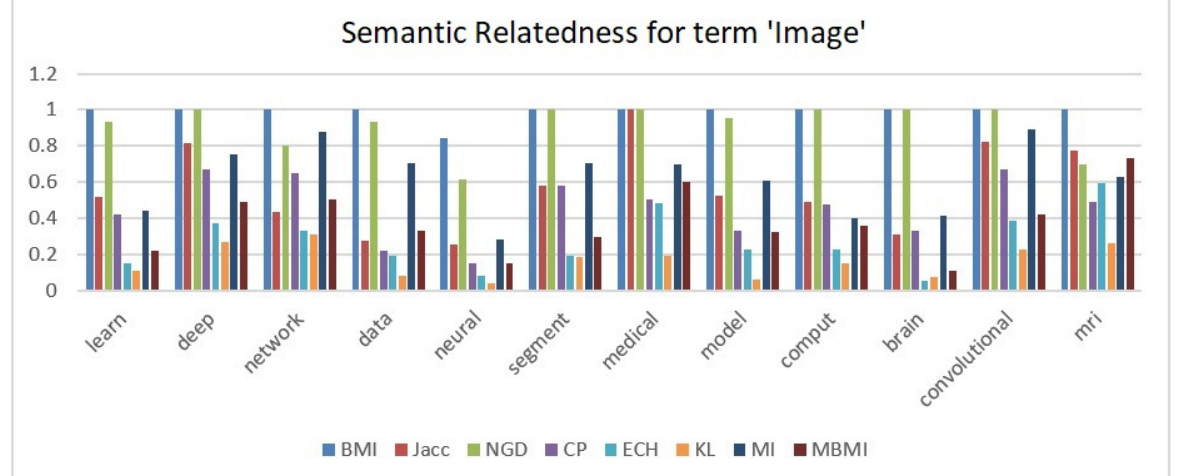
Figure 8. Semantic Similarity of term “Image” with terms using different techniques